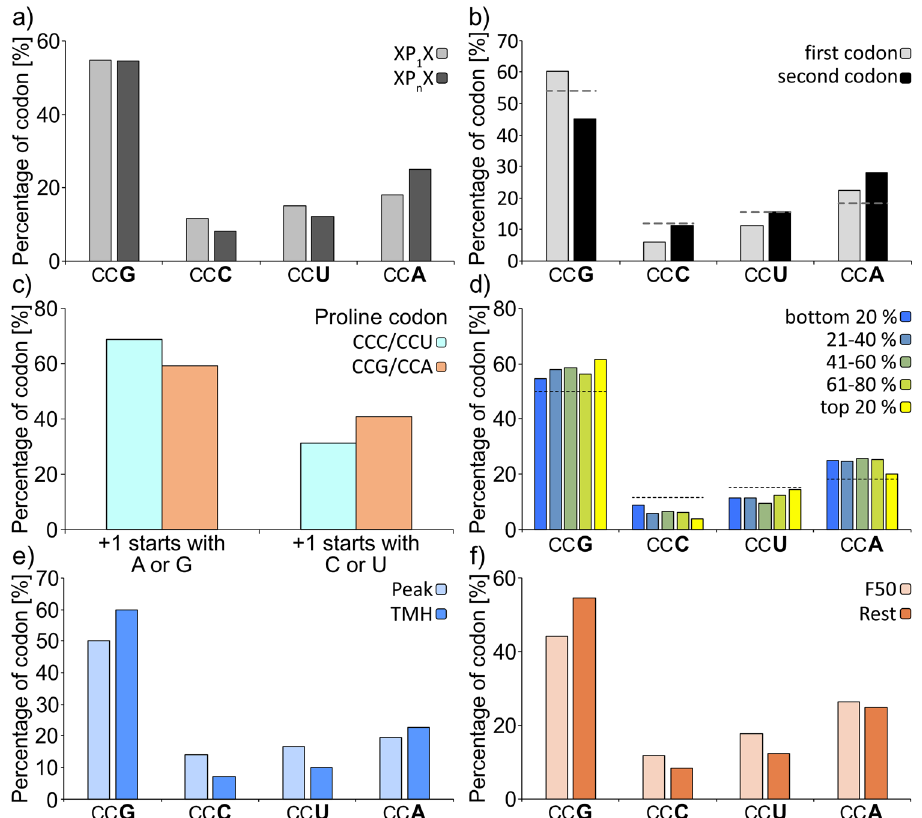
Fig. 2 Bioinformatic analysis of proline codon bias in E. coli . a Codon usage of either single (XP 1 X) or consecutive (XP n X) prolines (with X being any amino acid except proline and n > 1). p value = 1.7e − 30, chi-squared test. b Codon usage of the fi rst and second proline in PP-motifs. Only PP-motifs with two consecutive proline residues were included in this analysis. The dashed lines indicate the codon usage for single prolines. p value < 2.2e − 16, chi- squared test. c Codon usage for amino acids in the + 1-position downstream CCC/CCU (cyan) or CCG/CCA (orange) encoded single prolines. p value < 2.2e − 16, chi-squared test. d Correlation between proline codon usage in PP-motifs and translation ef fi ciency from least ef fi ciently translated proteins (dark blue) to most ef fi ciently translated proteins (yellow). The dashed lines indicate the codon usage for single prolines. e Difference between proline codon usage of PP-motifs in the peak region (light blue, amino acids 49 – 59 from the TMH start where PP-motifs are enriched to facilitate the ef fi cient insertion of TMH into the membrane) and TMHs (blue; transmembrane helices in which PP-motifs are depleted for proper folding of transmembrane segments 11 . p value = 0.13, chi-squared test. f Proline codon usage in PP-motifs in the fi rst 50 codons (light orange) compared with the rest of proteins (orange). p value = 2.14e − 7, chi-squared